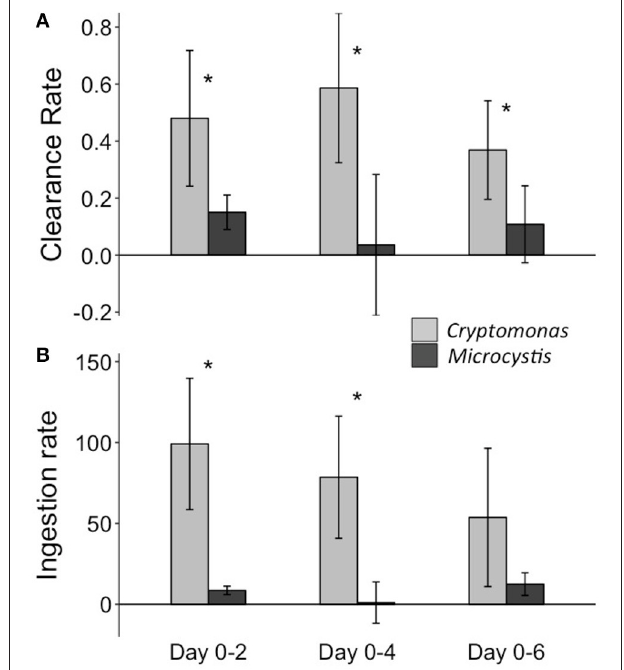
FIGURE 7 | Mean prey specific rates of (A) clearance (mL.copepod − 1 .hour − 1 ) and (B) ingestion (ng.copepod − 1 .hour − 1 ) of N. iheringi on Cryptomonas and Microcystis , measured across different time periods (i.e., 0–2, 0–4, 0–6 days) during the facilitation experiment. Error bars show the 95% confidence intervals. *Represents a significant difference (i.e., p < 0.05) between grazing rates on each prey type for a given time